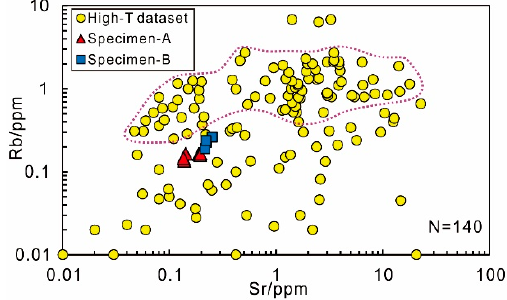
Figure 7. Rb-Sr concentration data are compared between pyrite in this study and pyrite samples in high-temperature ore systems (log-log scale). Rb-Sr data sources: